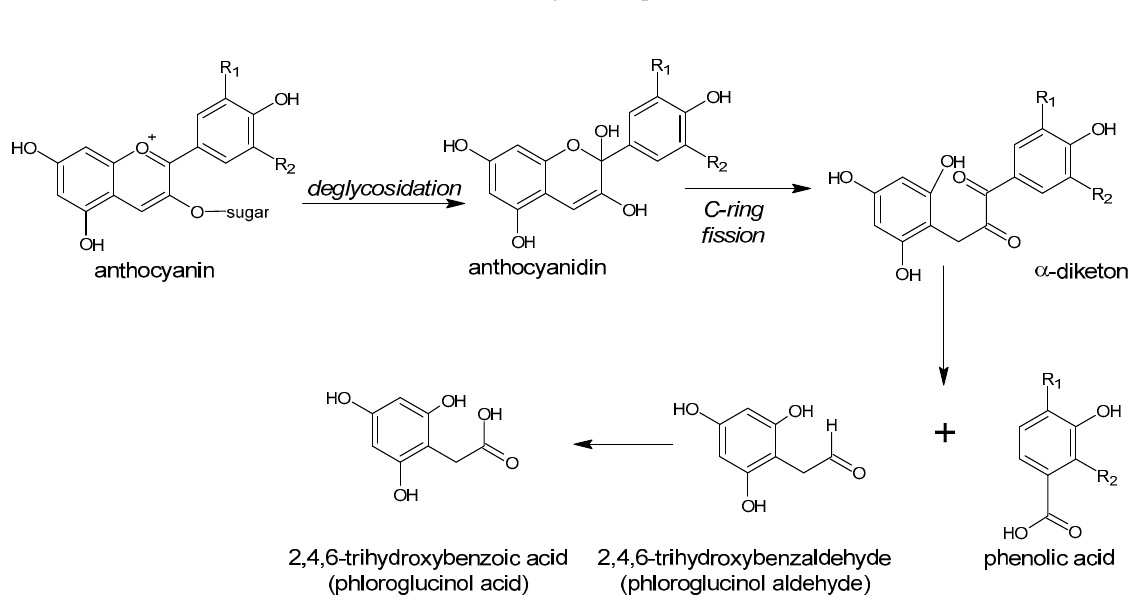
Figure 12. Anthocyanins equilibria [39].